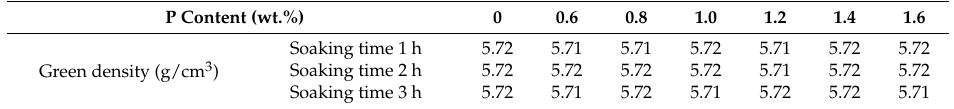
Table 2. A summary of sintering densities of Fe-x P (x = 0, 0.6, 0.8, 1.0, 1.2, 1.4 and 1.6 wt.%) samples sintered at 1000 ◦ C for different time. Figure 2. Sintering densities of Fe-0.8%P samples sintered at different temperatures for 2 h ( a ), and those sintered at 900 °C and 1000 °C for different periods of time ( b ). Figure 3. Sintering densities of samples with different P contents, which are sintered at 1000 °C for 1, 2, and 3 h. Table 1. A summary of green densities of Fe-x P (x = 0, 0.6, 0.8, 1.0, 1.2, 1.4, and 1.6 wt.%) samples sintered at 1000 °C for different times.